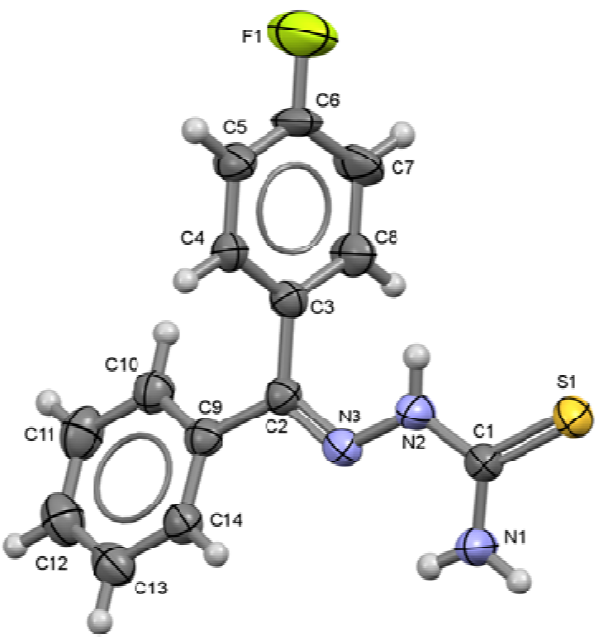
Figure 6. ORTEP drawing of 4-C are shown at 50% of probability. Selected bond lengths (Å) and angles (°): S1-C1 1.686(5), C1-N1 1.316(5), C1-N2 1.347(6), N2-N3 1.374(5), N3-C2 1.278(6), C2-C3 1.495(5), C2-C9 1.488(6), C6-F1 1.346(6); S1-C1-N1 123.8(3), S1-C1-N2 119.3(3), N1-C1-N2 116.9(4), N2-N3-C2 118.1(3), N3-C2-C3 123.8(4), N3-C2-C9